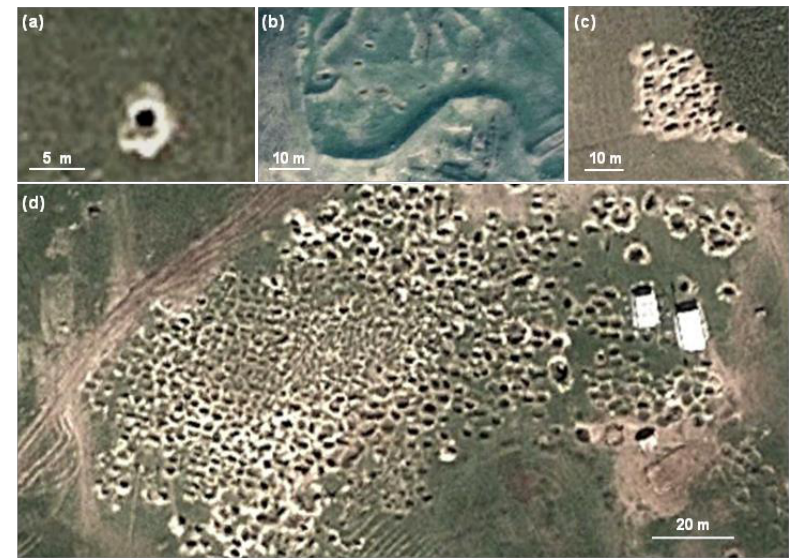
Figure 7. Examples of typical looting features in satellite VHR optical images covering vegetated sites: ( a ) single, isolated, circular looting pit; ( b ) low density cluster of looting pits; ( c ) high density cluster of looting pits; ( d ) extended looted areas with coalescence of looting pits. Google Earth images © 2019 Maxar Technologies.